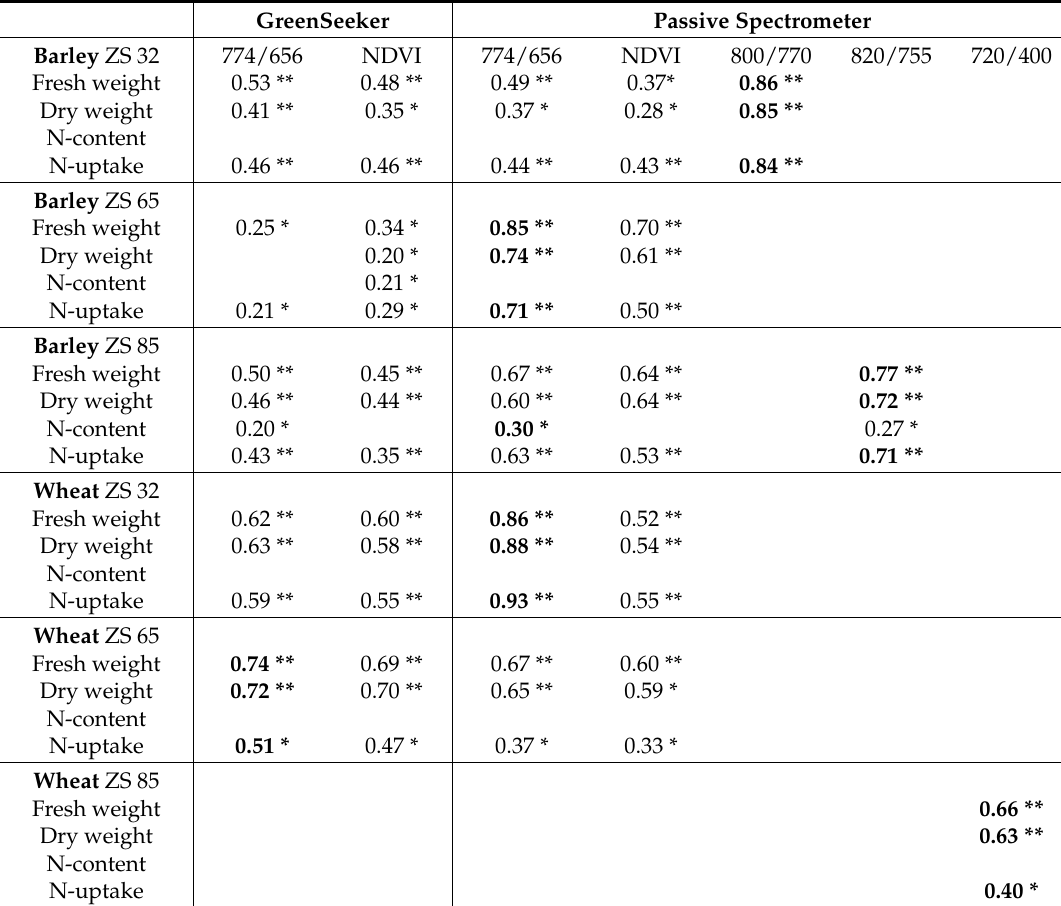
Table 2. Significant relationships between sensor measurements and plant parameters of wheat and barley, indicated by coefficients of determination (R 2 ) at * p ≤ 5%, ** p ≤ 1%. Relationships are indicated for different indices. The closest relationships are indicated in